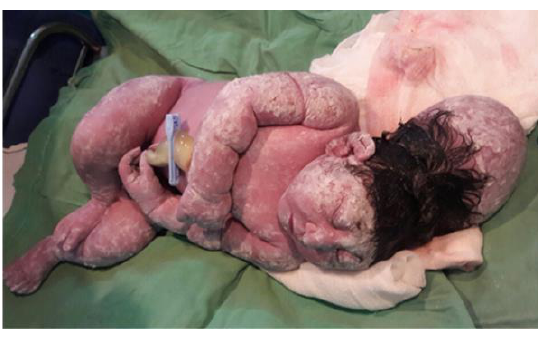
Figure 3. Acalvaria; demonstrating the absence of cranium with developed brain covered with the